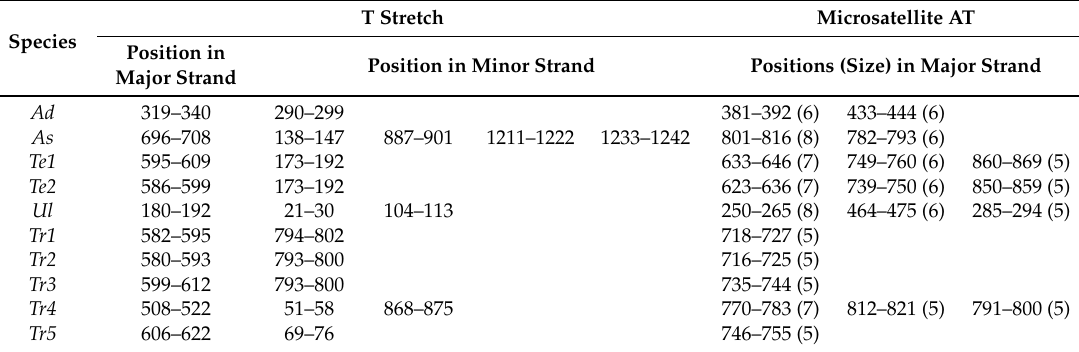
Table 3. T stretch in both coding strands and the microsatellite AT in major strand of the AT-rich region from ten Tenebrionidae